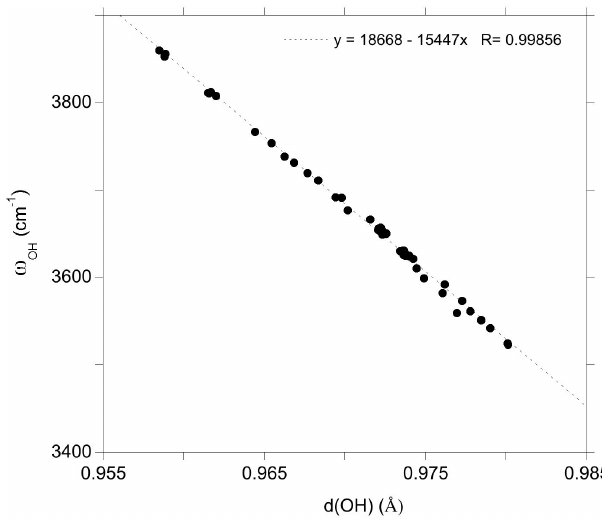
Figure 3. Difference between the OH stretching frequencies com- puted using a simple hexagonal cell and a larger 1 × 1 × 2 super- cell ( (cid:49)ω OH = ω OH ( simple ) − ω OH ( supercell ) ) reported as a func- tion of the frequencies computed for the 1 × 1 × 2 supercell (Ta- ble 1). Squares: V (OH) groups; circles: W (OH) groups. Full sym- bols: models with a vacant X site; open symbols: models with full Na occupation of X